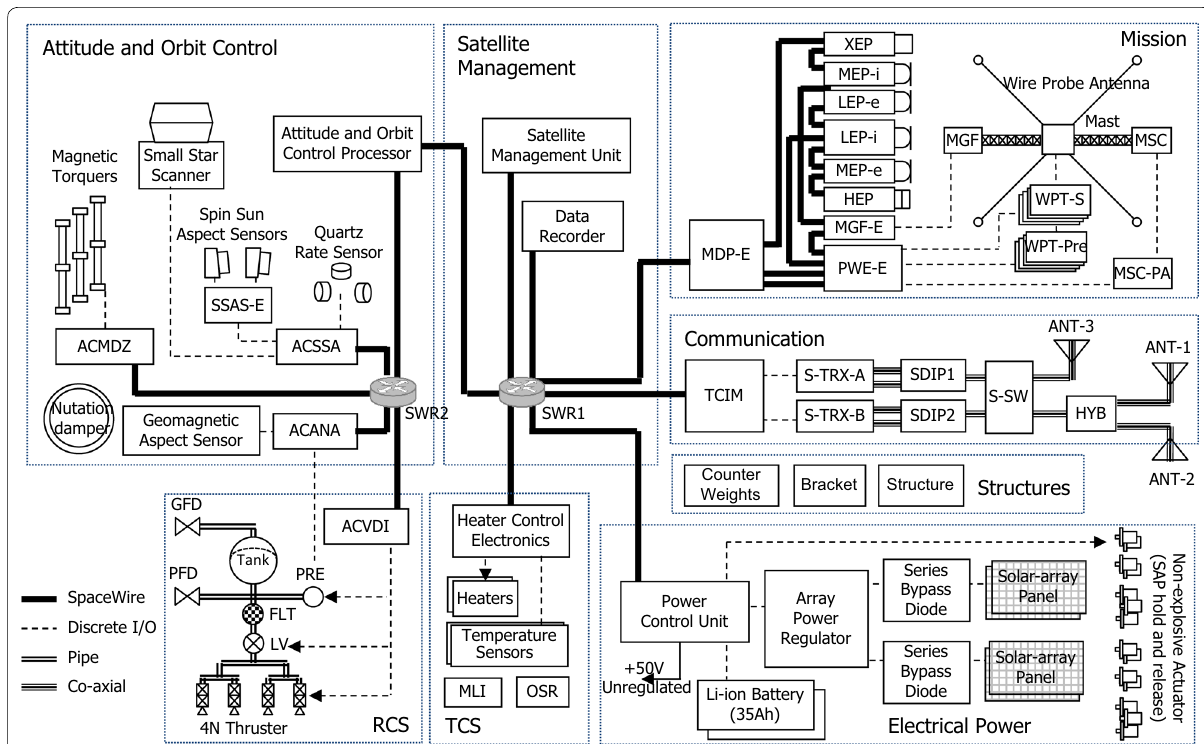
Fig. 4 System block diagram. The bold lines delineate the three different SpaceWire networks within the ERG satellite system. The first one is for the management subsystem. A satellite management unit, a data recorder, a telemetry and command interface module, an attitude and orbit control processor, a power control unit, a heater control unit, and mission data processor electronics are connected through SpaceWire network router 1. The second network is for the attitude and orbit control subsystem. Within the network, the AOCP is connected to four attitude control interface modules (ACSSA, ACMDZ, ACANA, and ACVDI) through SpaceWire network router 2, and each ACIM is connected to the AOCS sensors and actuators. The last network is dedicated to the mission operations. Each mission instrument has a SpaceWire router and consists of a ring‑type network when considered in the aggregate system